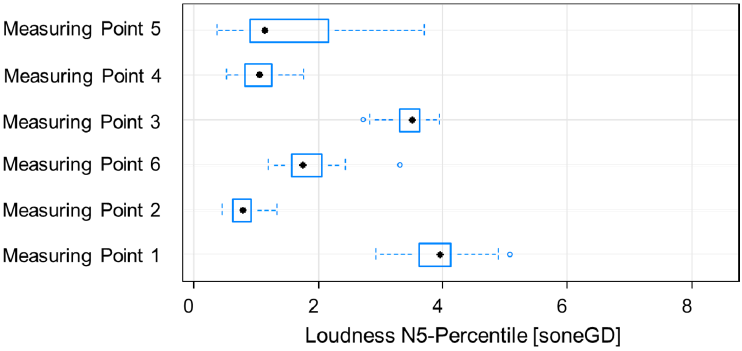
Figure 9. Loudness N5 ‐ Percentile in (soneGD) at each measuring point for all passing tramways.